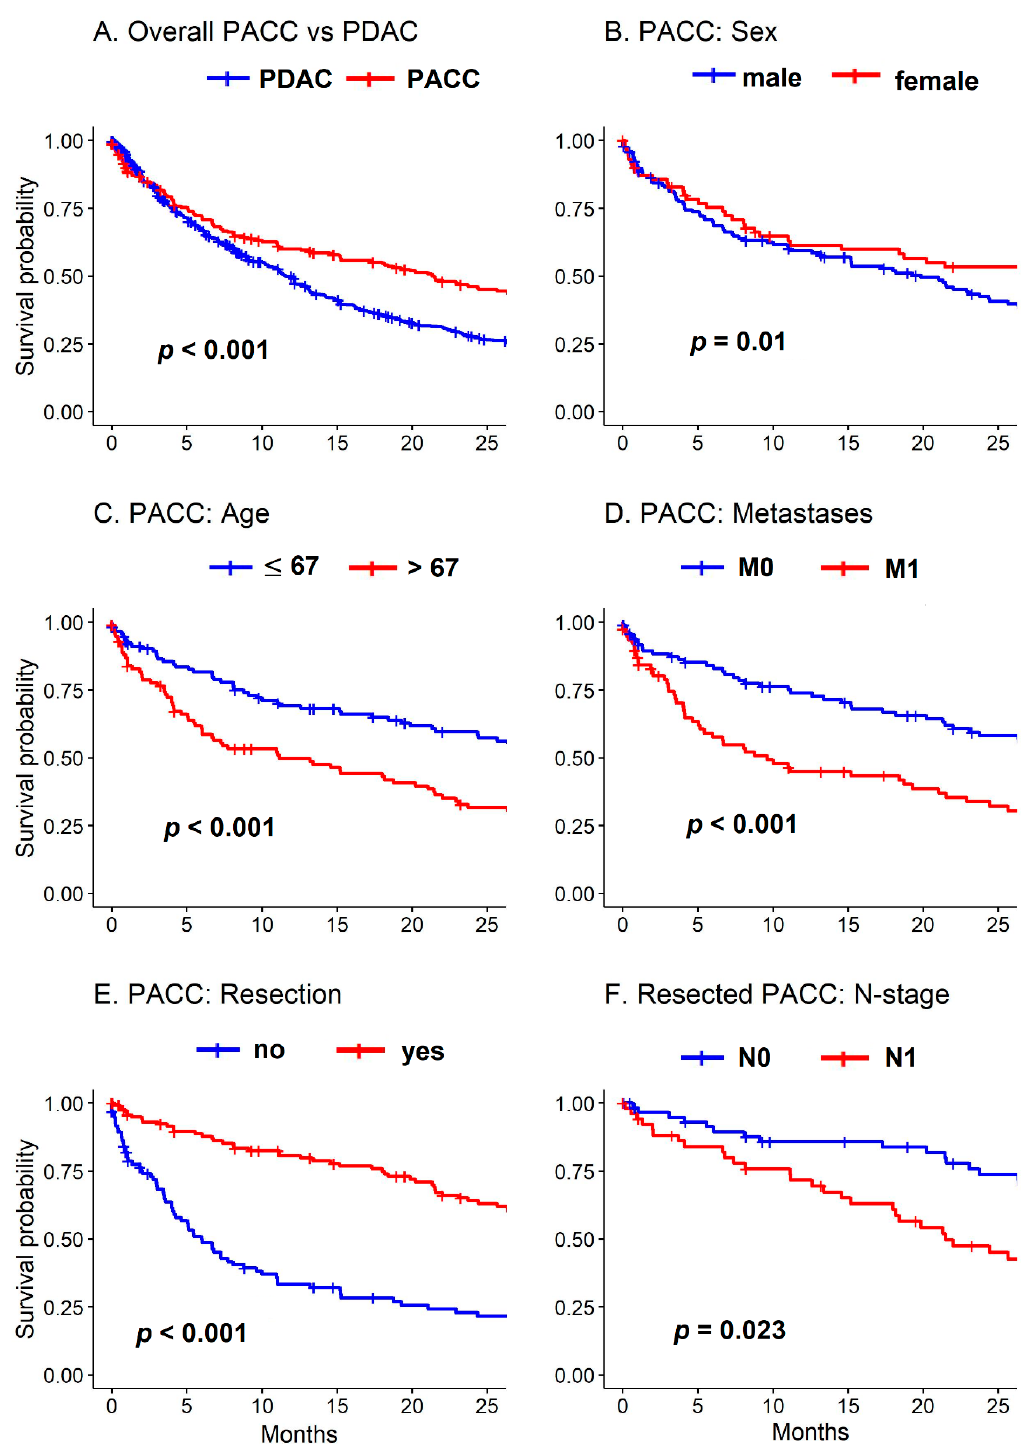
Figure 2. Survival of PACC and matched PDAC cohorts. ( A ) Overall survival of PACC versus PDAC. ( B ) Survival of PACC patients according to sex. ( C ) Survival of PACC patients according to age (67 years or younger versus older than 67 years). ( D ) Survival of PACC patients according to distant metastases. ( E ) Survival of PACC patients according to resection versus no resection. ( F ) Survival of PACC patients according to lymph node metastases.